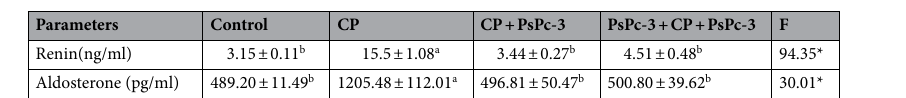
Table 2. Effect of PsPc-3 on renin and aldosterone. The data are means ± SE ( n = 8). One-way ANOVA followed by Tukey’s multiple comparison post hoc test; the differences were considered significant at P ≤ 0.05. Small letters (a, b) indicate a statistically significant difference. F (*) indicates a statistically significant difference. a P < 0.05 versus control, CP + PsPc-3, and PsPc-3 + CP + PsPc-3, b P > 0.05 versus control.